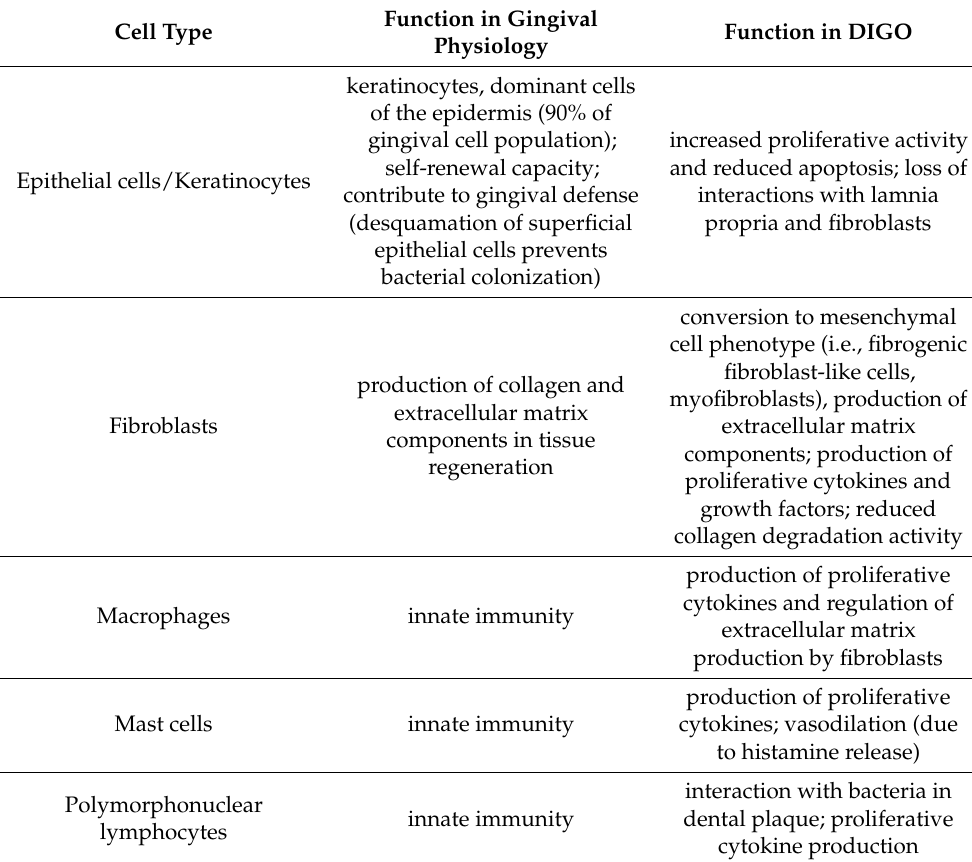
Table 2. Principal cells in